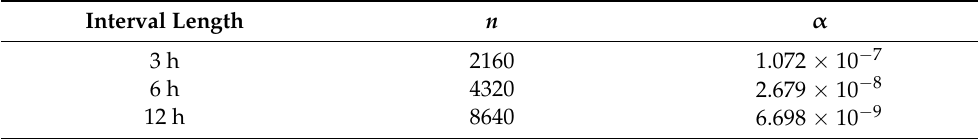
Table 3. Significance threshold α scaled according to sample size n .